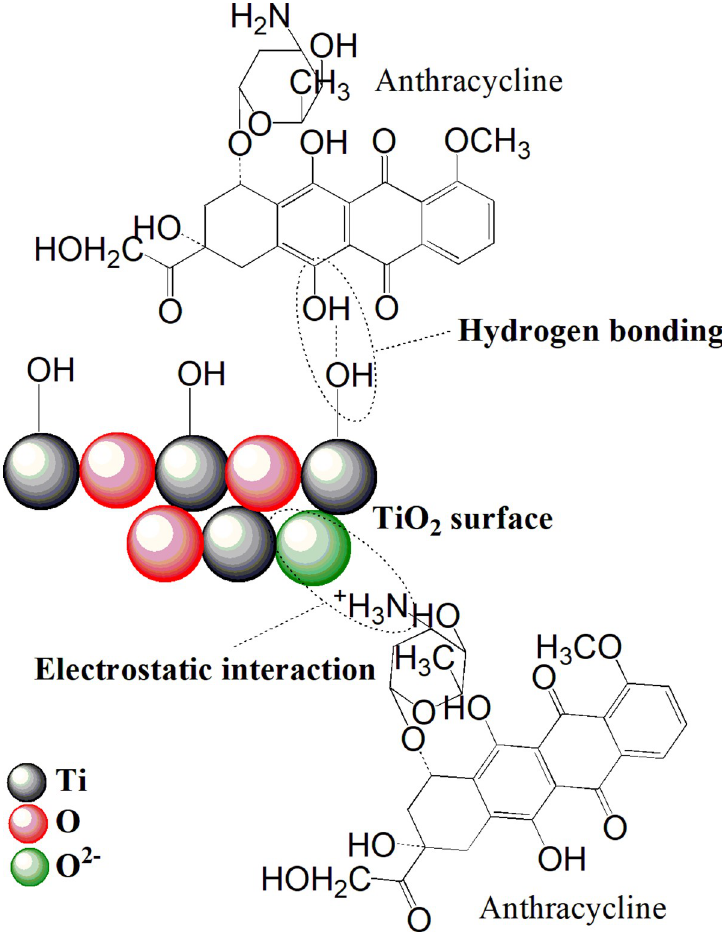
Fig 15. The scheme of the adsorption interaction between anthracycline molecules and TiO 2 nanoparticles.